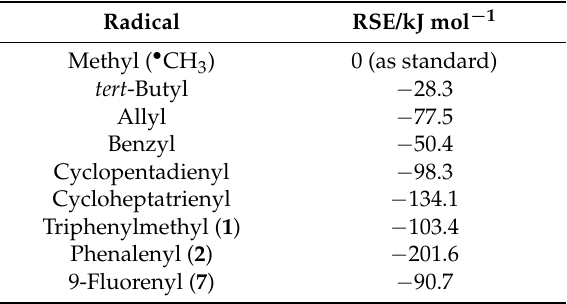
Table 1. Radical stabilization energies (RSEs) of selected carbon-centered